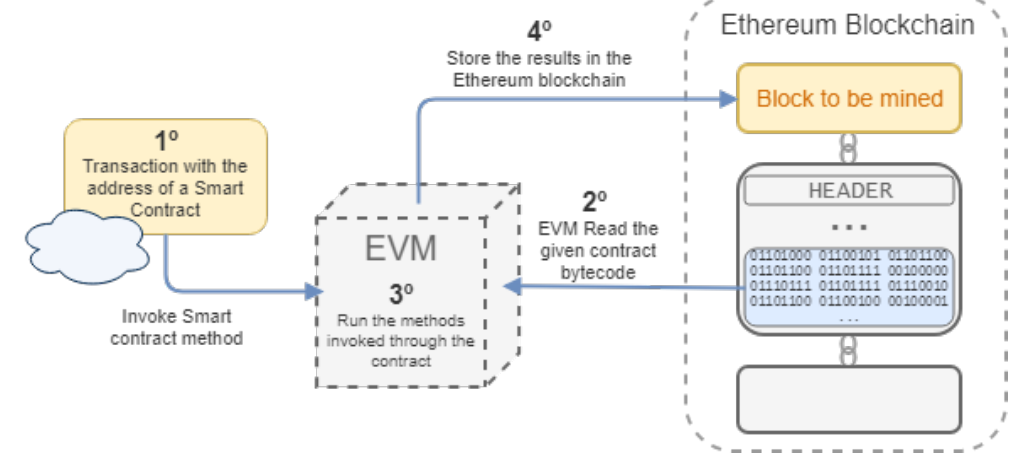
Figure 14. Invocation of a Smart Contract method.